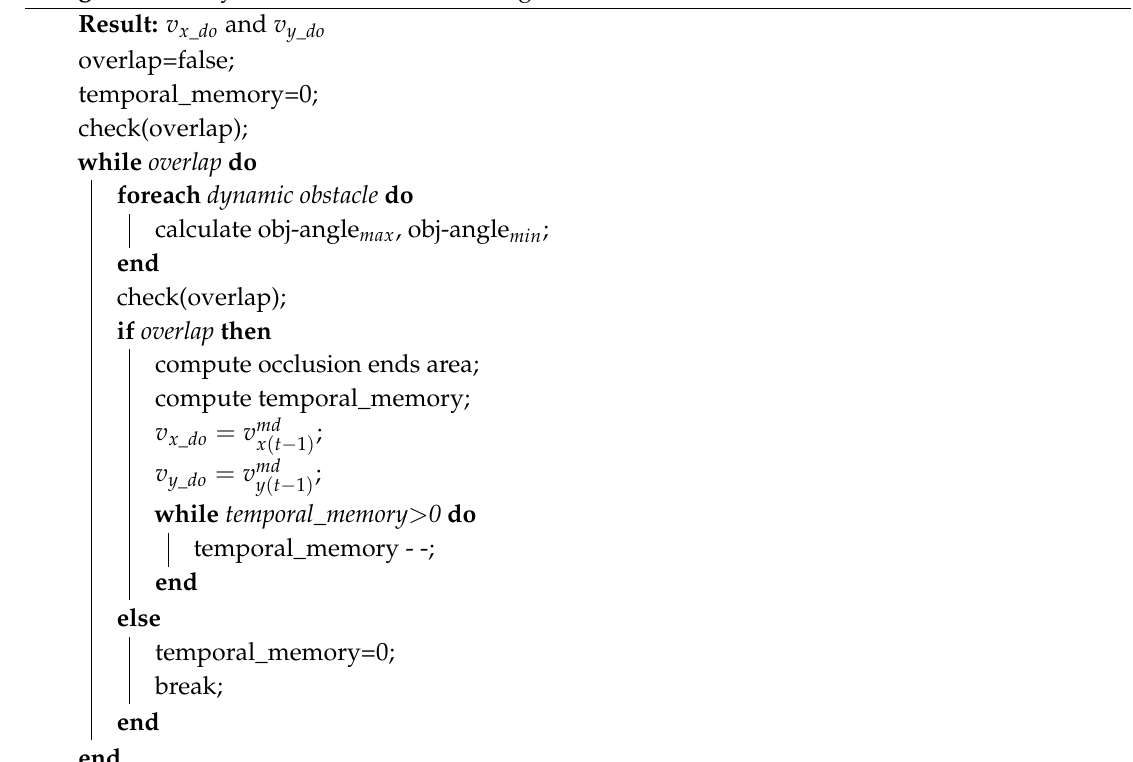
Algorithm 1: Dynamic obstacle detector